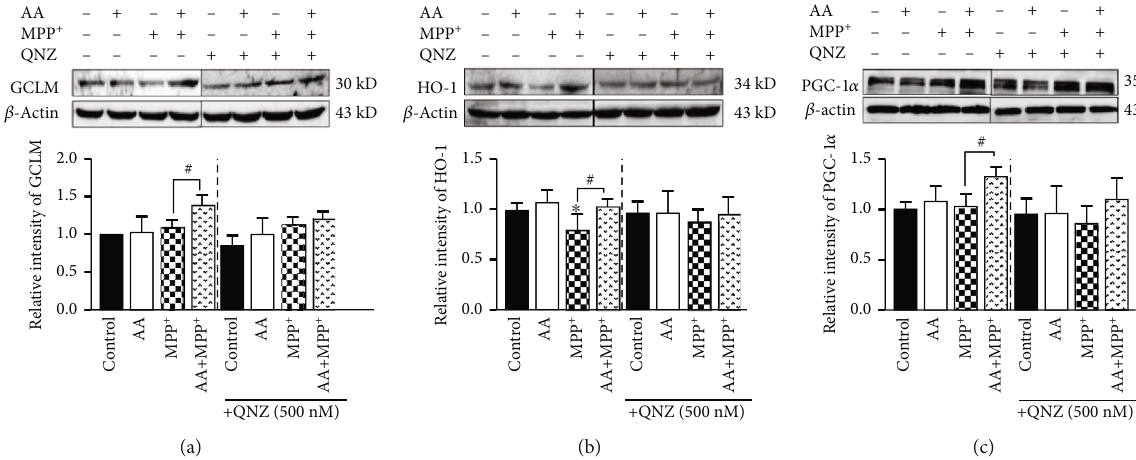
Figure 5: Inhibition of NF- κ B signaling suppresses the expression of antioxidative proteins and blocks the protective e ff ects of ascorbic acid to perpetuate cytotoxicity in MPP + -treated in astrocytes in vitro . Primary astrocytes were copretreated with 1mM of AA and 0.5mM of QNZ (EVP4593) for 24 h and/or 1 mM of MPP + for another 24h. (a) The expression of GCLM was detected by Western blotting ( n = 3 ). (b) The expression of HO-1 was detected by Western blotting ( n = 3 ). (c) The expression of PGC-1 α was detected by Western blotting ( n = 3 ). Data were obtained from three independent experiments. One-way ANOVAs followed by LSD pairwise comparisons were performed. ∗